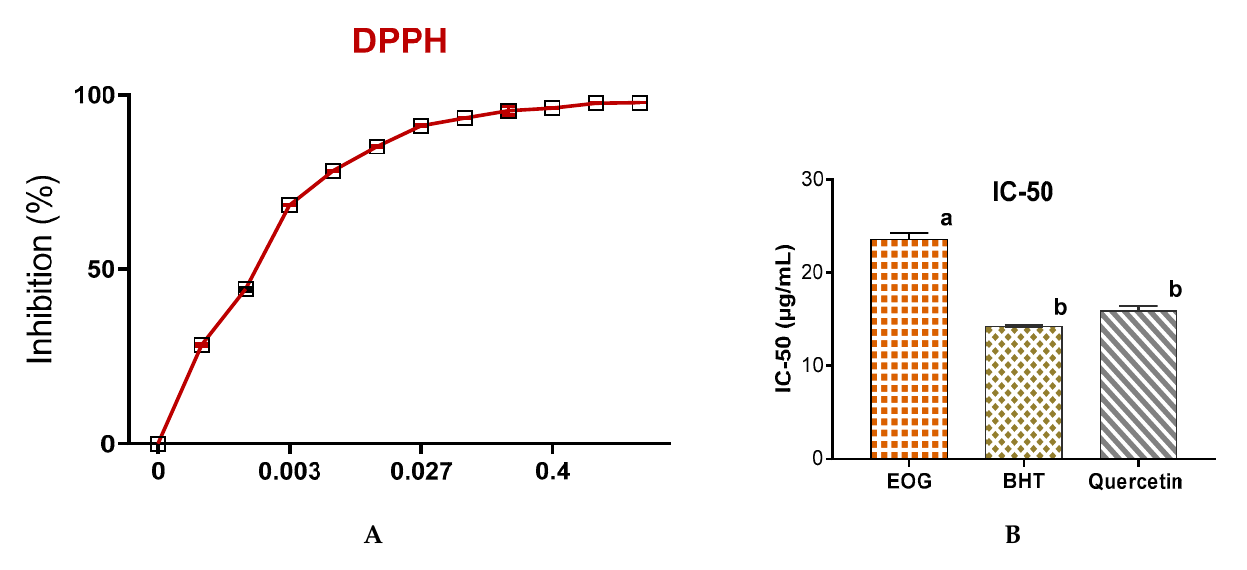
Figure 3. Antioxidant activities of EOs of J. thurifera by the DPPH method ( A ) and the concentration of IC-50 ( B ). Bars with the same letters do not differ significantly (p < 0.05).